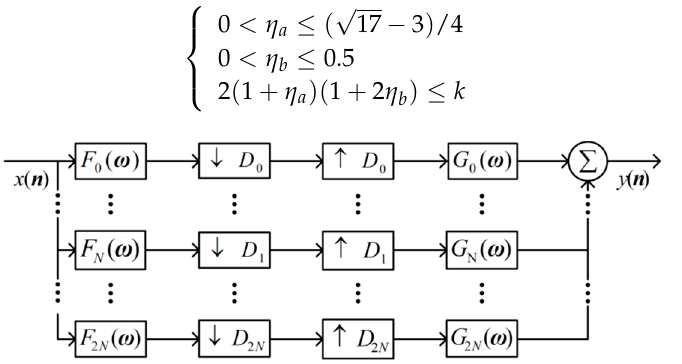
Figure 3. Structure of the UDCT filter bank.